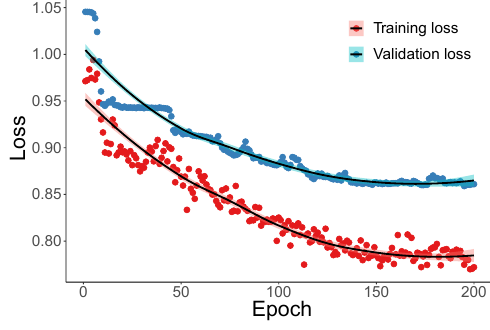
Figure 16. Loss of SAE.